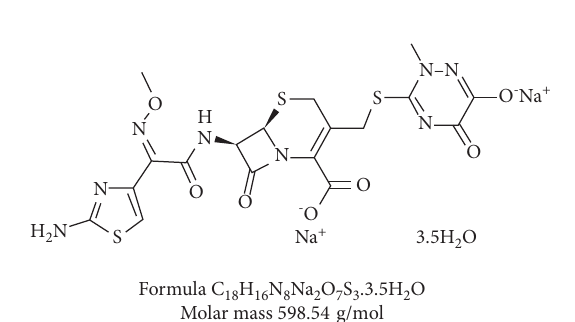
Mass fraction purity was provided by the suppliers.